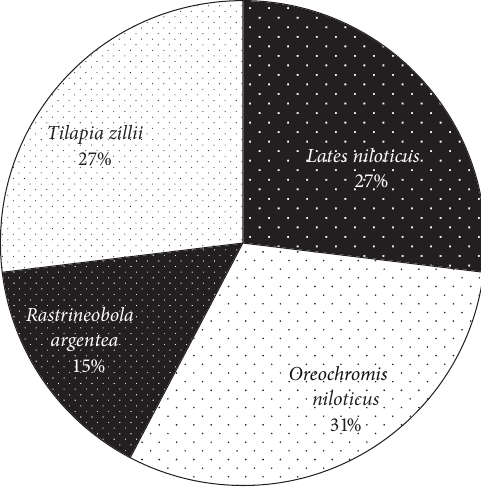
Figure 2: Types of 𝜔 3 PUFAs in the four commercial fish species.